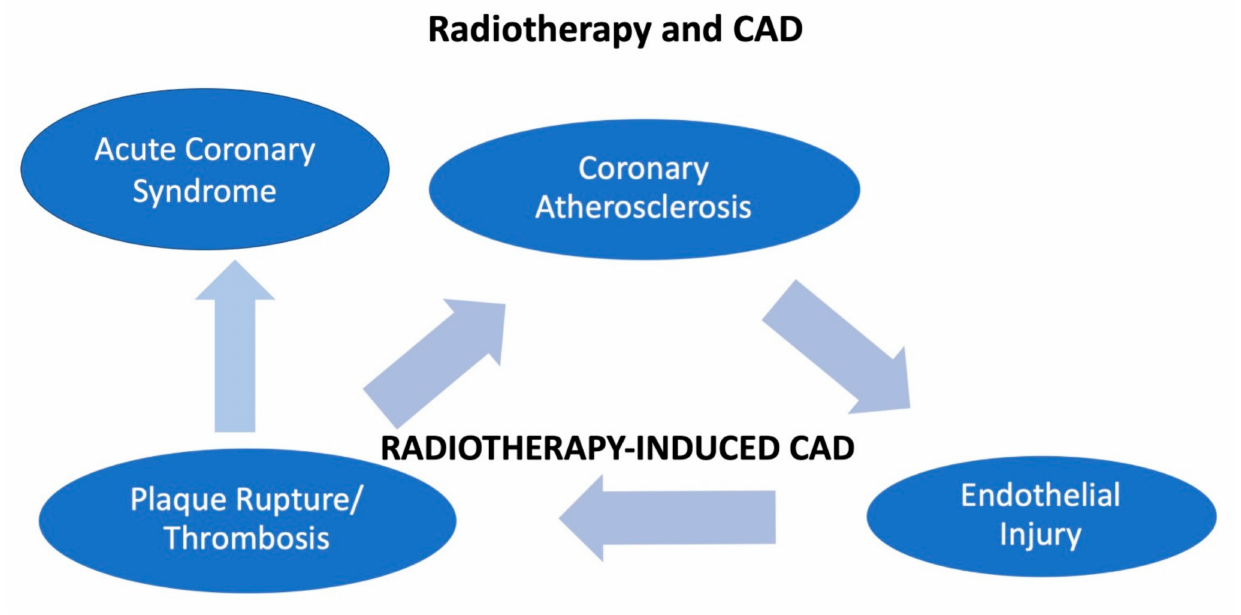
Figure 3. The figure shows how radiotherapy may induce coronary disease and acute coronary syndrome in patients with